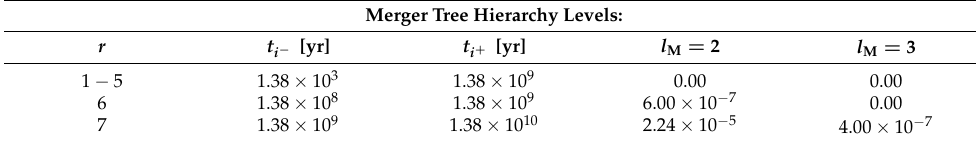
Table 10. Fraction of mergers grouped from the time slices dividing the first five time-runs. Each level l M indicates the level in the merger tree hierarchy, with l M = 2 indicating the merger two PBHs onto a final one, and l M = 3 indicating the merger of three PBHs onto single PBH, accumulated in the